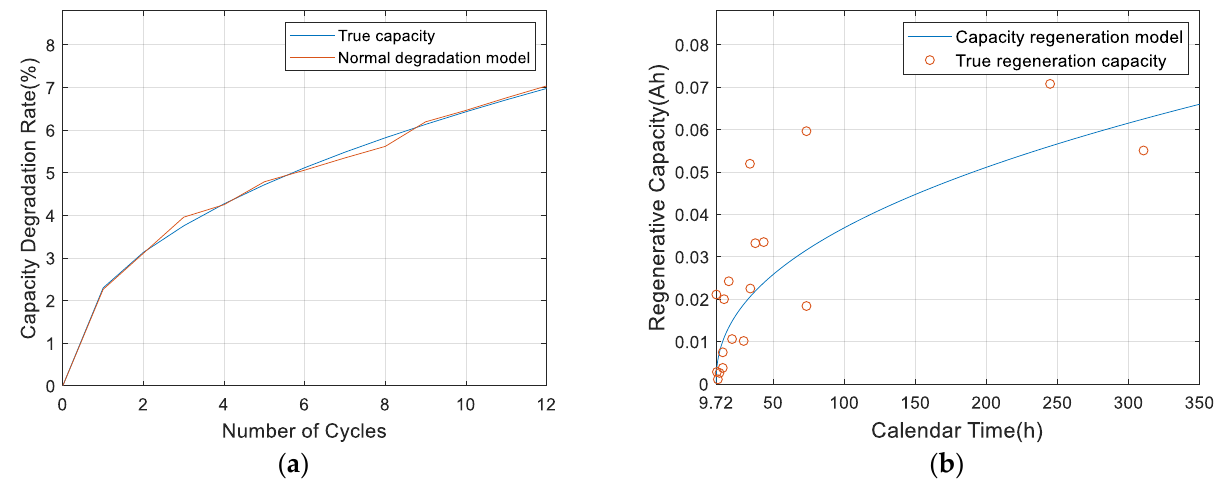
Figure 8. ( a ) Normal degradation model curve; ( b ) capacity regeneration model curve.